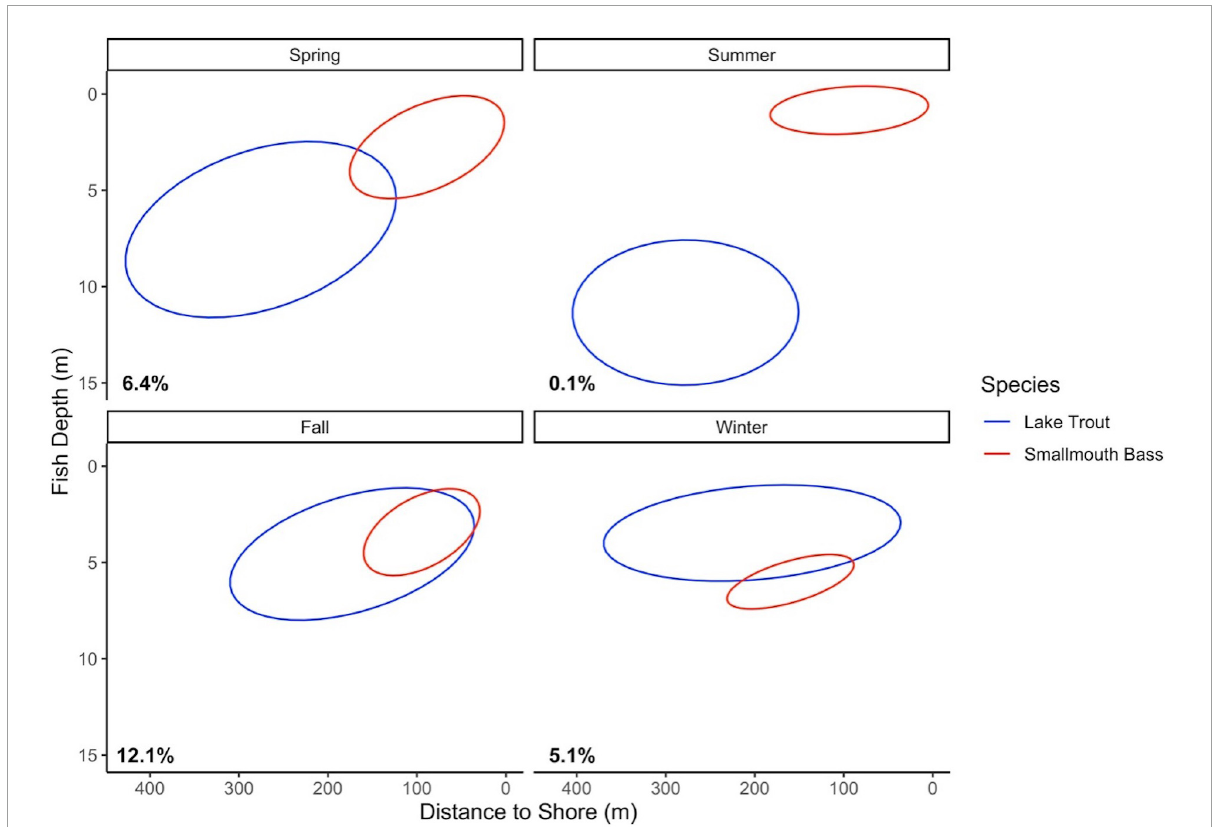
FIGURE3 Habitat ellipses (40%) for lake trout (blue) and smallmouth bass (red), based on the niche axes fish depth (m) and distance to shore (m). The percent probability that a random lake trout will be in the 40% habitat niche space of smallmouth bass, calculated using the nicheROVER package, is in the lower left corner. Data were collected between spring 2017 and winter 2019 (two annual cycles) from an acoustic telemetry array in Lake 2 (– cisco). Results are separated into spring, summer, fall, and